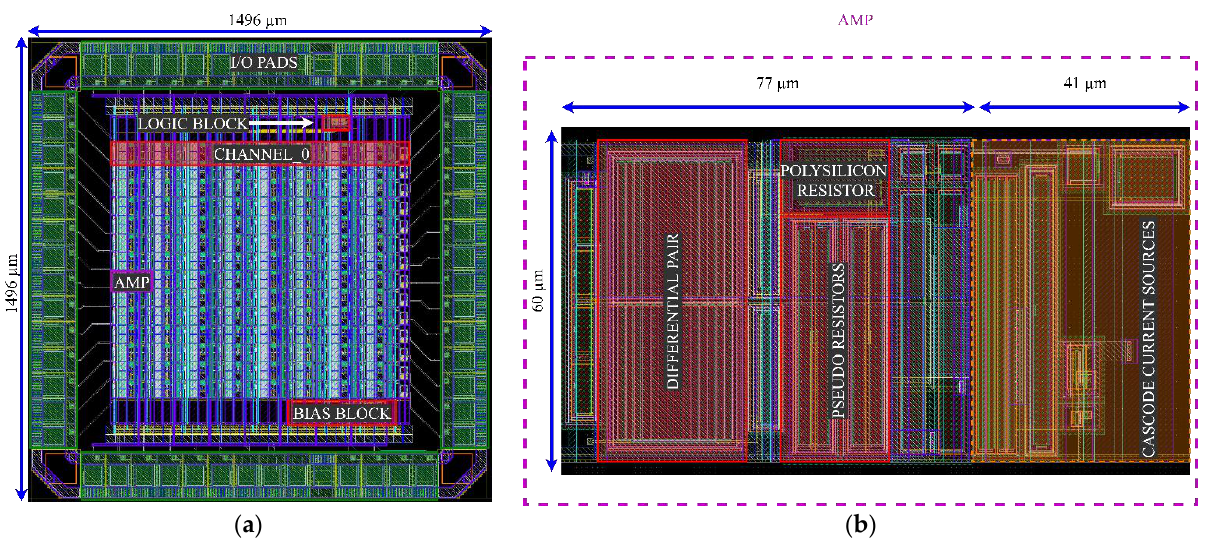
Figure 12. ( a ) Layout of the test integrated curcuit; ( b ) Layout of the preamplifier for the test chip. The elements inside the orange rectangle include the cascode transistors ( M P , M PC , M NC , M N —compare with Figure 11c) and an output buffer; these blocks will not be included in the final preamplifier design shown in Figure 11b. The layout of the preamplifier is 118 μm × 60 μm (77 μm × 60 μm for the final design).